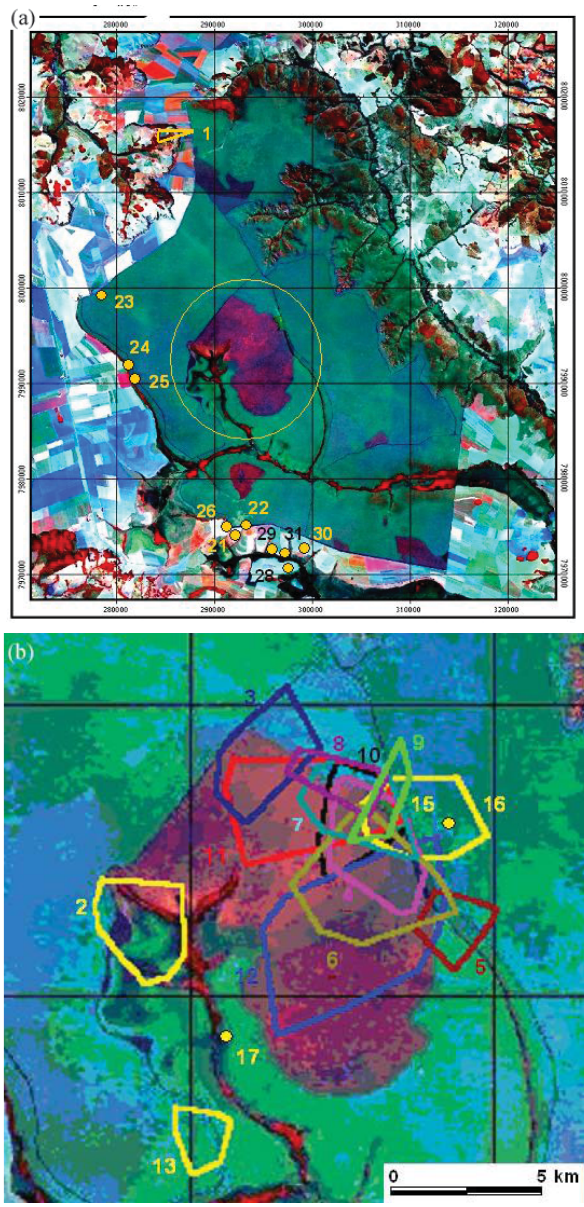
Figure 1 - LANDSAT V satellite image for 2002 of the Emas National Park, Brazil (darker area) showing the locality of the Myrmecophaga tridactyla specimens sampled. Figure 1X represents the center of the park circled in Figure 1a. Yellow circles represent the capture localities and polygons represent the home range. Animals in the center of the map (see detail in Figure 1X) belong to subpopulation I (SPI; specimens TBC02 to TBC13, and TBC15, TBC16, TBC17 and TBC20), at the bottom of the map (a) to subpopulation II (SPII; TBC21, TBC22, TBC26, TBC28 to TBC31) and at the left and upper part of the map to the peripheral group (TBC01, TBC23, TBC24, TBC25). The prefix TBC was omitted for clar-